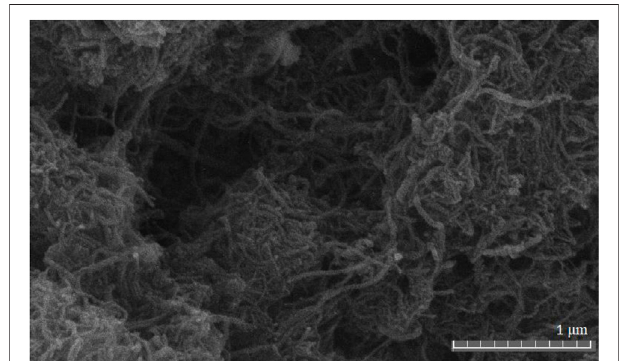
FIGURE 6 | Schematic diagram of sensor